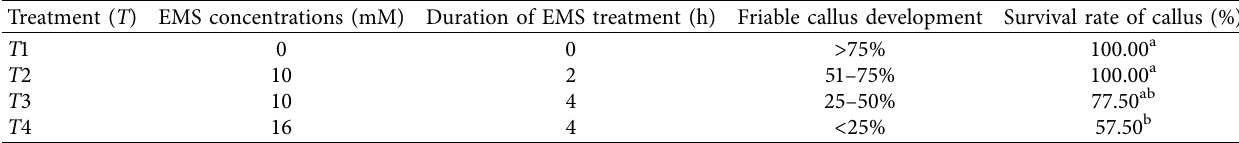
Table 2: Influence of ethyl methanesulfonate (EMS) mutagenesis conditions on survival rate and friable callus development.